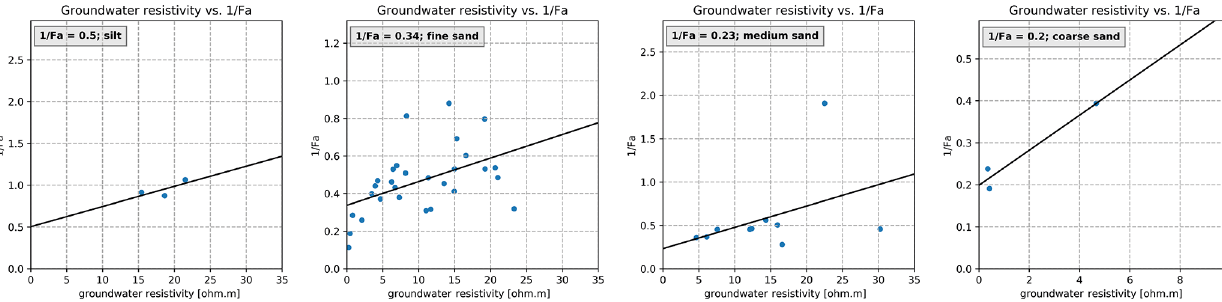
Figure B2. Relation between groundwater resistivity and 1 /F a for four lithologies, from which F i is